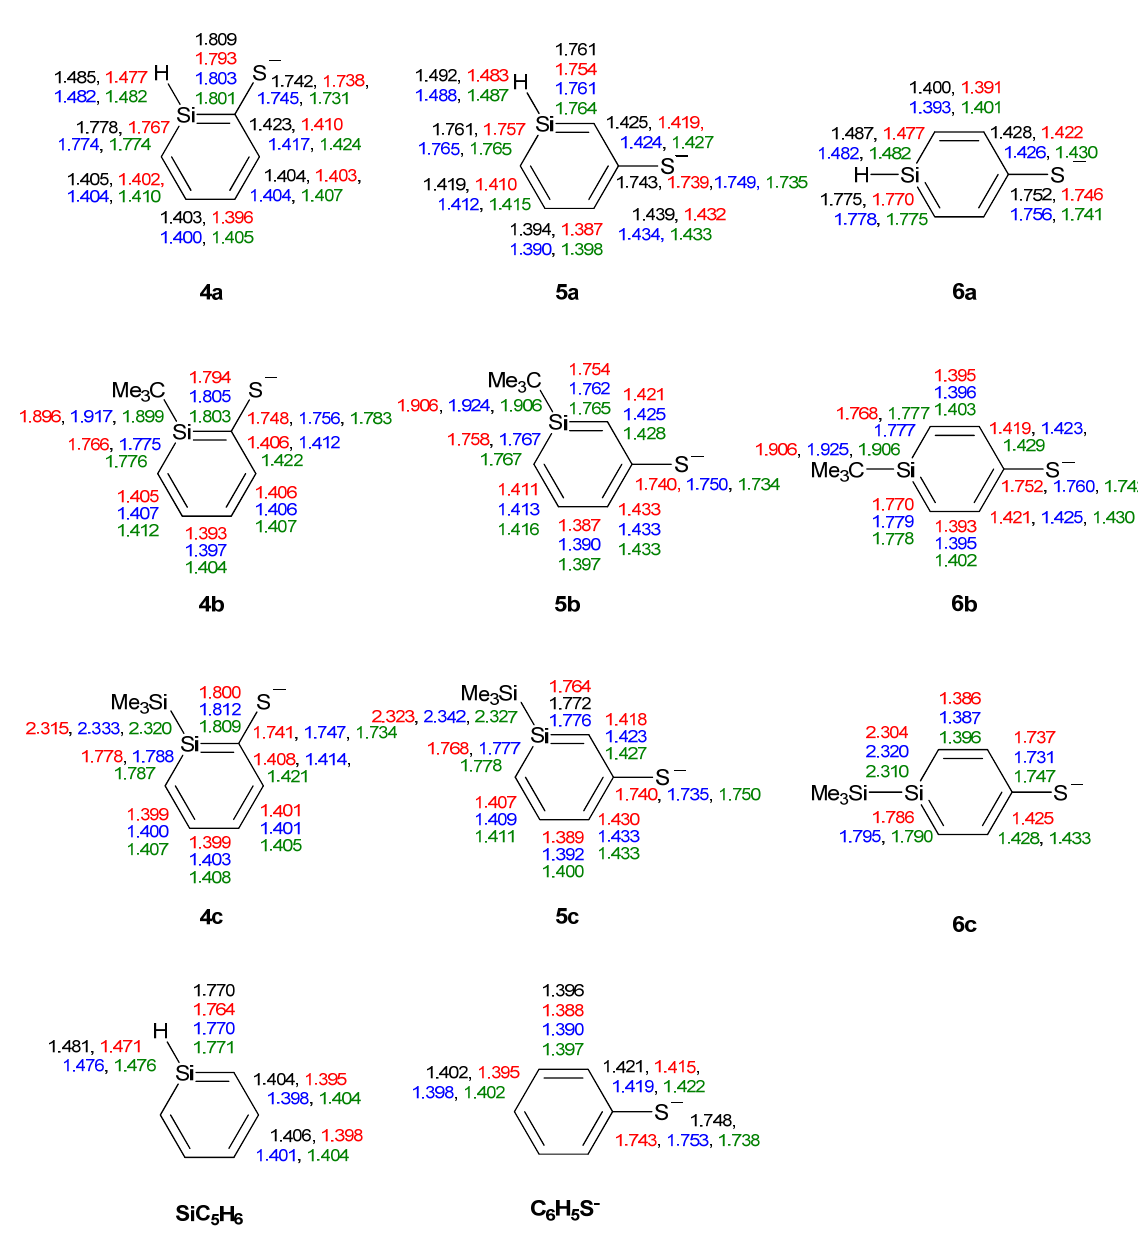
Figure 7. Bond lengths (Å) of silaphenylthiolates 4a – 6c , parent silabenzene, and phenylthiolate C H S - calculated at CCSD/6-311G(d) (black), M062X/6-311G(d) (red), 6 5 B3LYP/6-311G(d) (blue), and MP2/6-311G(d) (green) levels. All sums of valence angles at Si ( Σα (Si)) equal